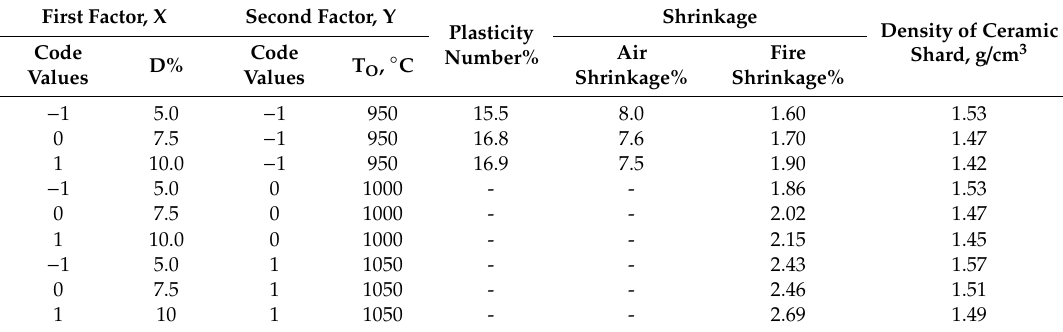
Table 4. Design matrix and responses of the two-factor experiment.